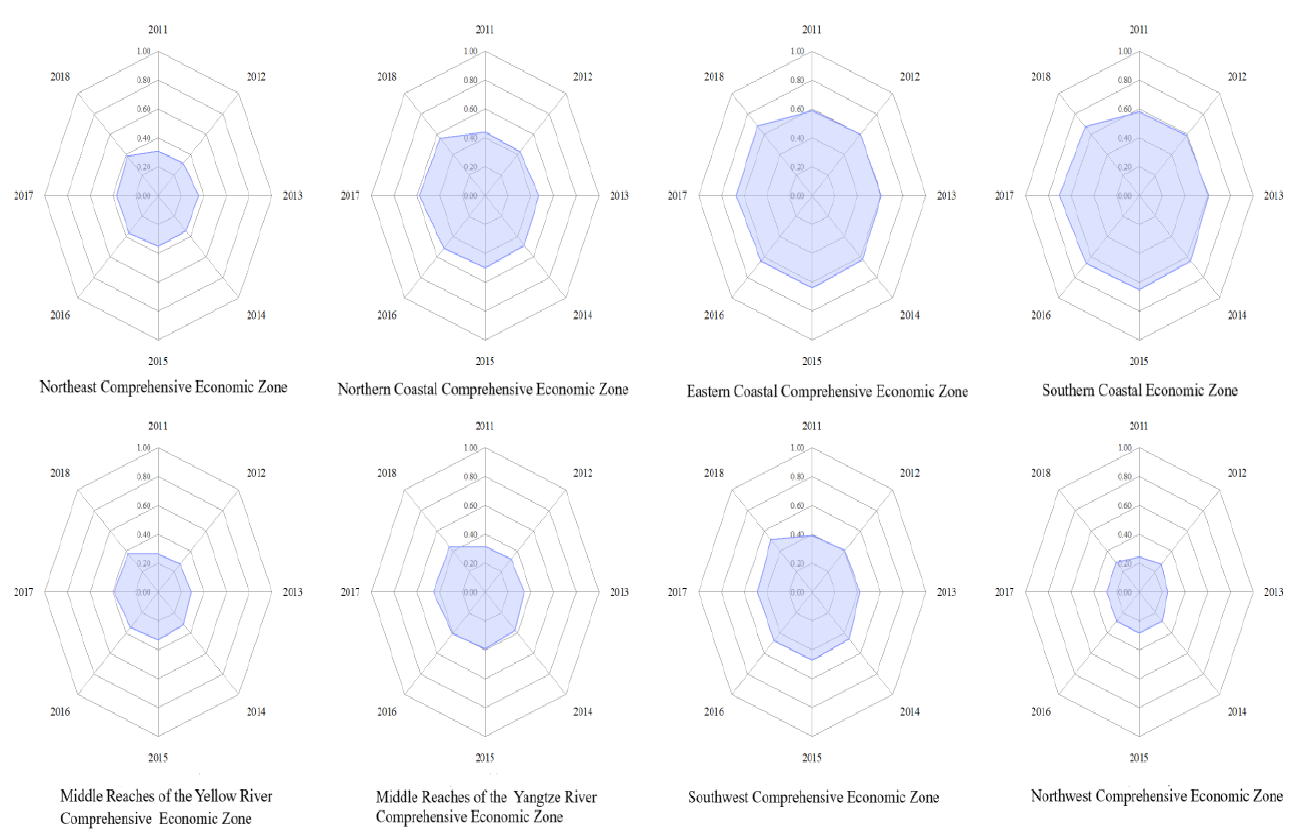
Figure 3. Status and characteristics of coupling and coordination of digital economy development and carbon emissions reduction in eight regions.